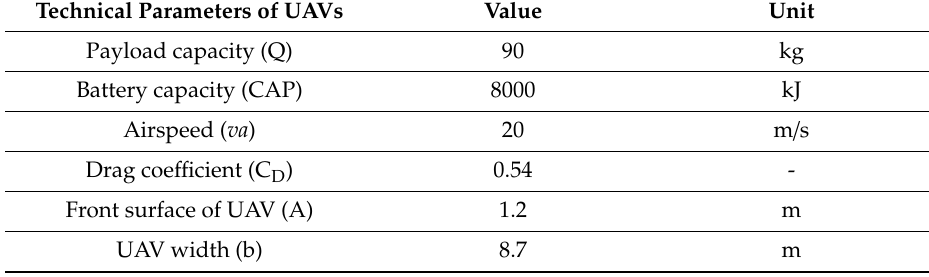
Figure 1. Transportation network. Table 1. Technical parameters.